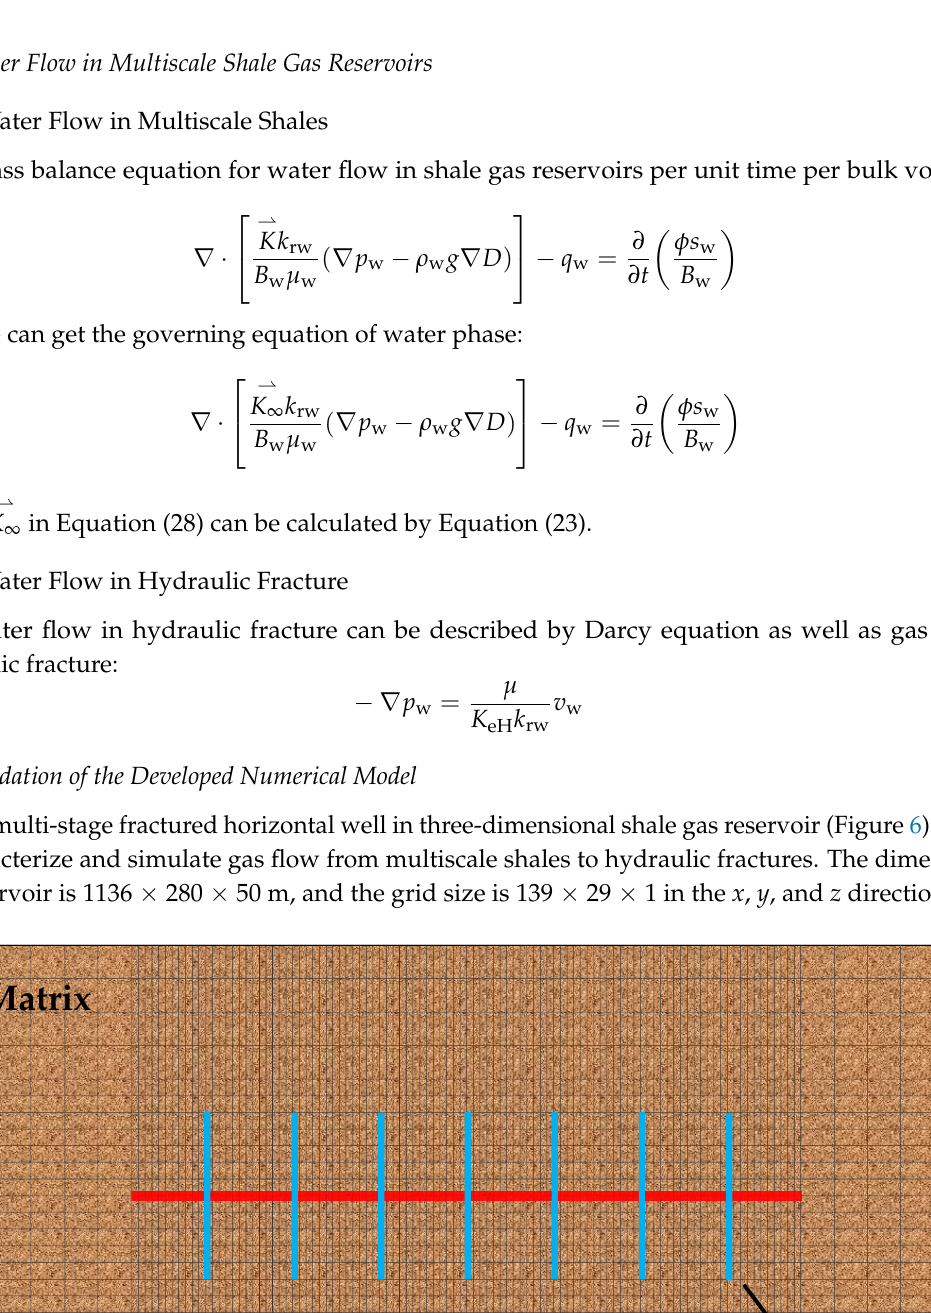
Table 2. Basic parameters for the numerical simulation.